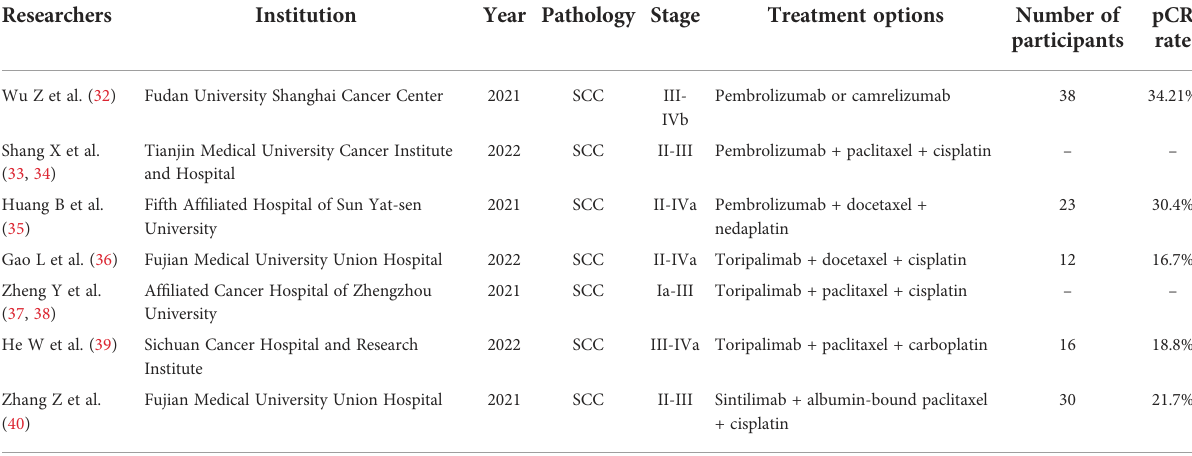
TABLE 6 Studies of ICIs (PD-1) in combination with neoadjuvant